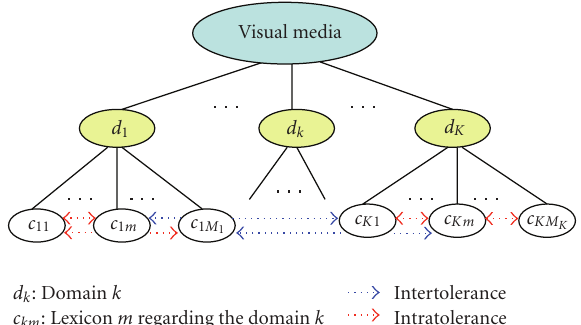
Figure 1: Form of